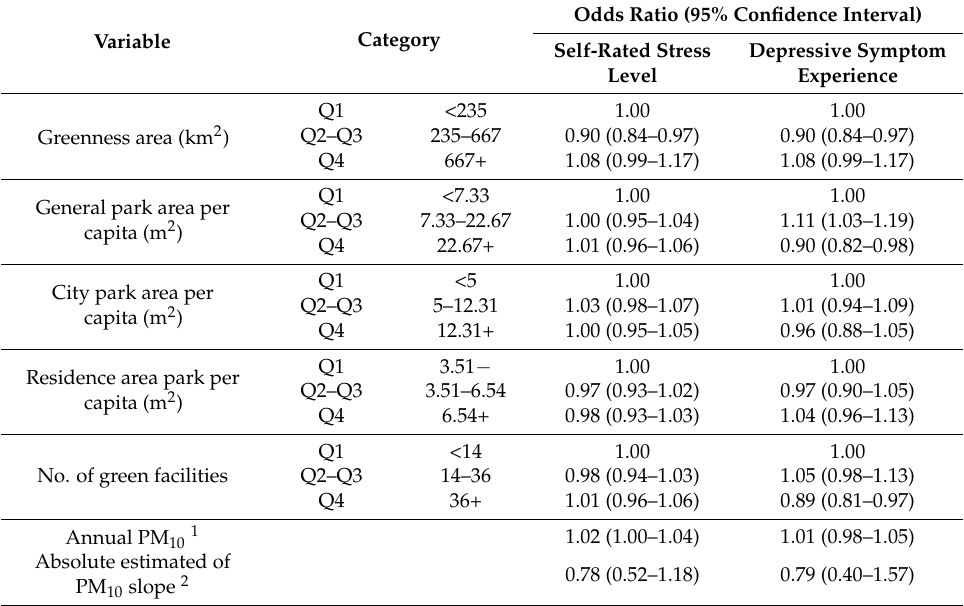
Table 4. Associations between self-rated mental health and community based